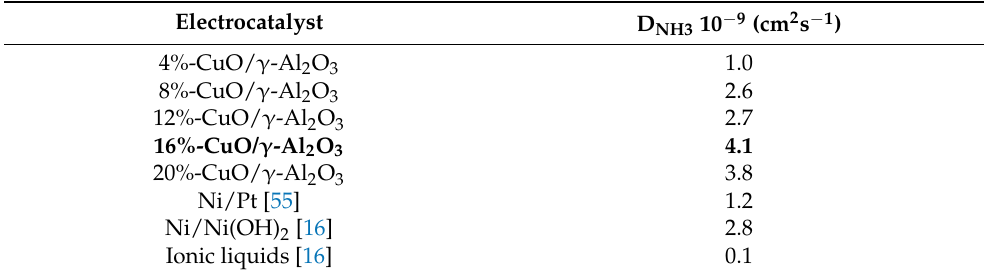
Table 3. Diffusion coefficients values for AEO using CuO/ γ -Al 2 O 3 modified electrodes in 0.1 M KOH at 25 ◦